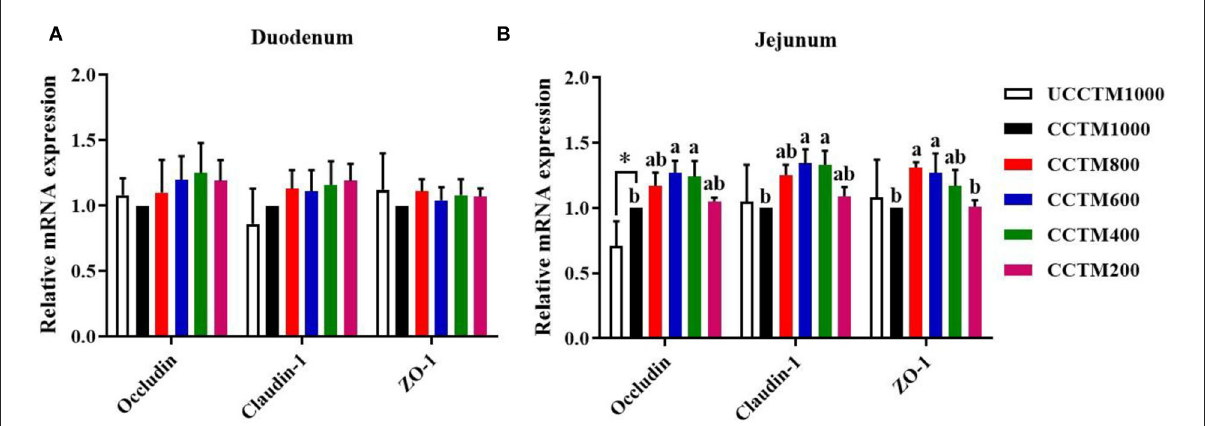
FIGURE5 Effects of dietary coated complex TMs on the expression of tight junction protein mRNA in the duodenal and jejunal mucosa of yellow-feathered broilers. RT-PCR quantification of occludin, claudin-1, and zonula occludens-1 in (A) duodenal and (B) jejunal mucosa. Results are mean value ± SE; n = 6 for each group. * P < 0.05 for the UCCTM1000 group vs. the CCTM1000 group. Mean values with different small letters denote significant differences among CCTM groups ( P < 0.05). UCCTM1000, supplemented with 1,000 mg/kg of uncoated complex trace minerals; CCTE1000, supplemented with 1,000 mg/kg of coated complex trace minerals; CCTE800, supplemented with 800 mg/kg of coated complex trace minerals; CCTE600, supplemented with 600 mg/kg of coated complex trace minerals; CCTE400, supplemented with 400 mg/kg of coated complex trace minerals; CCTE200, supplemented with 200 mg/kg of coated complex trace